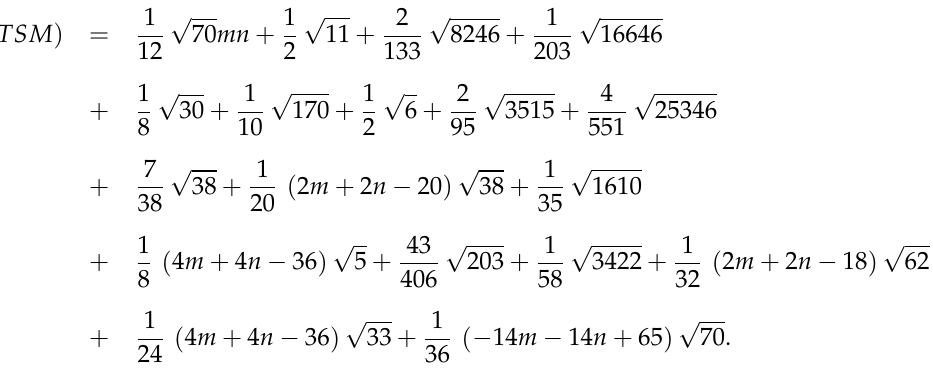
Table 3. The fourth atom-bond connectivity index ABC 4 is defined as: ABC 4 ( TSM )